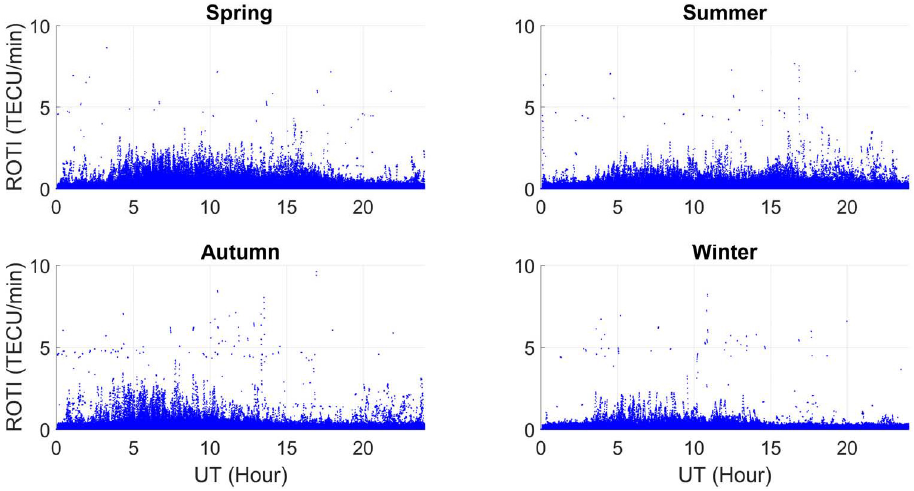
Figure 8. The time series of ROTI in UT for all of the observed GPS satellites at the WUHN site during the four seasons of 2012.